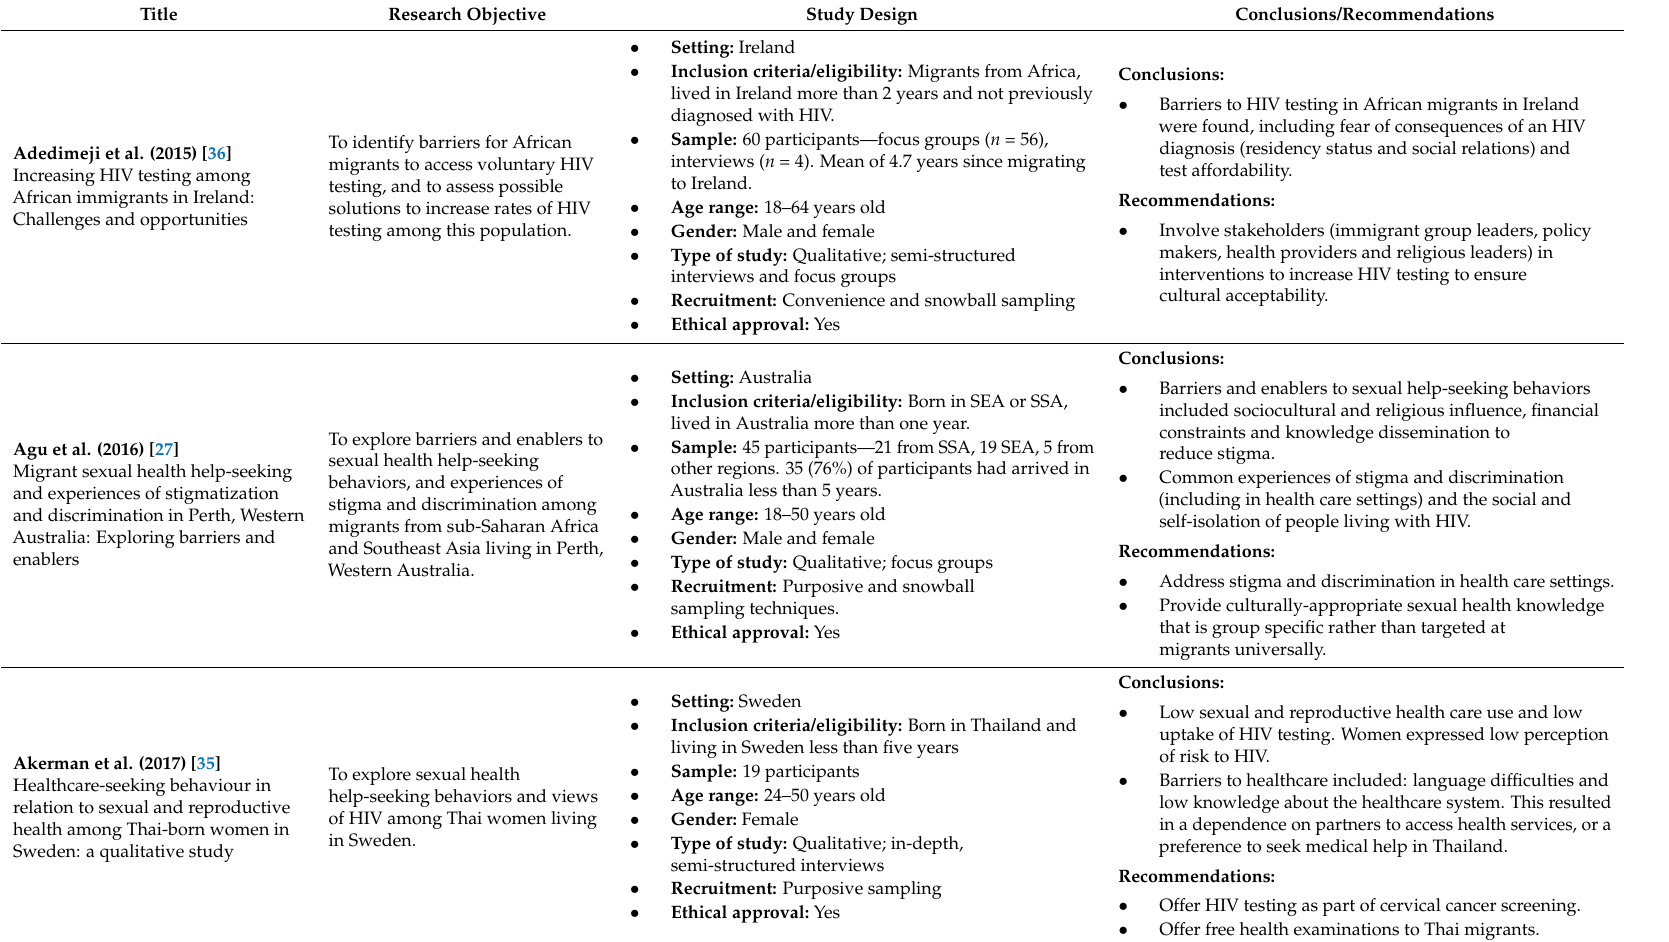
Table 2. General study characteristics, quality appraisal, and findings of fourteen studies addressing migrant sexual health help-seeking behavior in high income